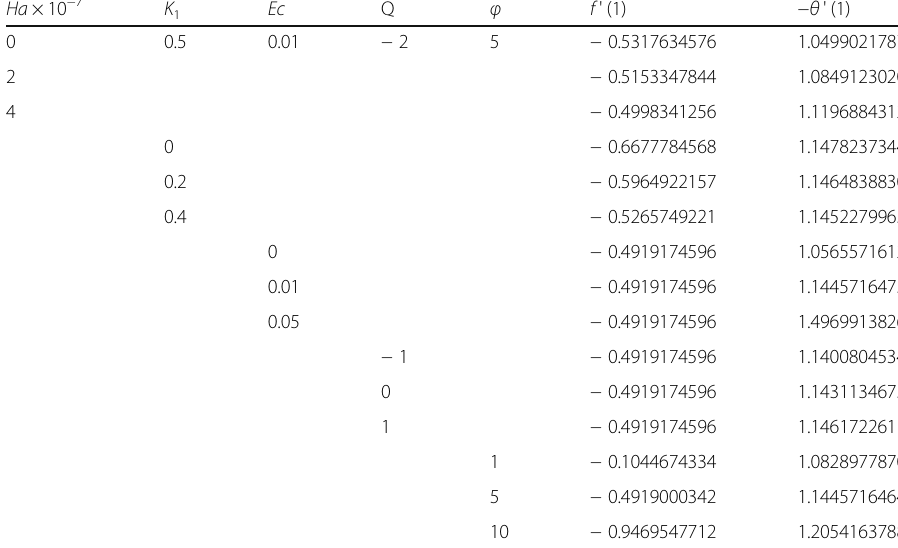
Table 3 Several values of f ' (1) and − θ ' (1) for stretching/divergent channel when Re = 50, Pr = 6.2, α = 5 0 , Rd = 0.2 λ = 1.5 , and